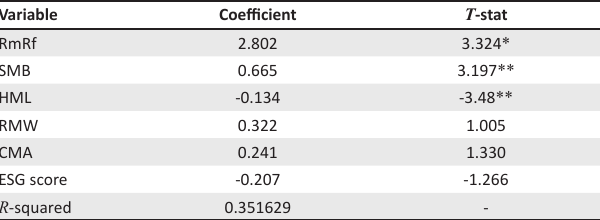
TABLE 2: Regression results for the adjusted Fama and French five-factor model (with environmental, social and governance score). Variable Coefficient T